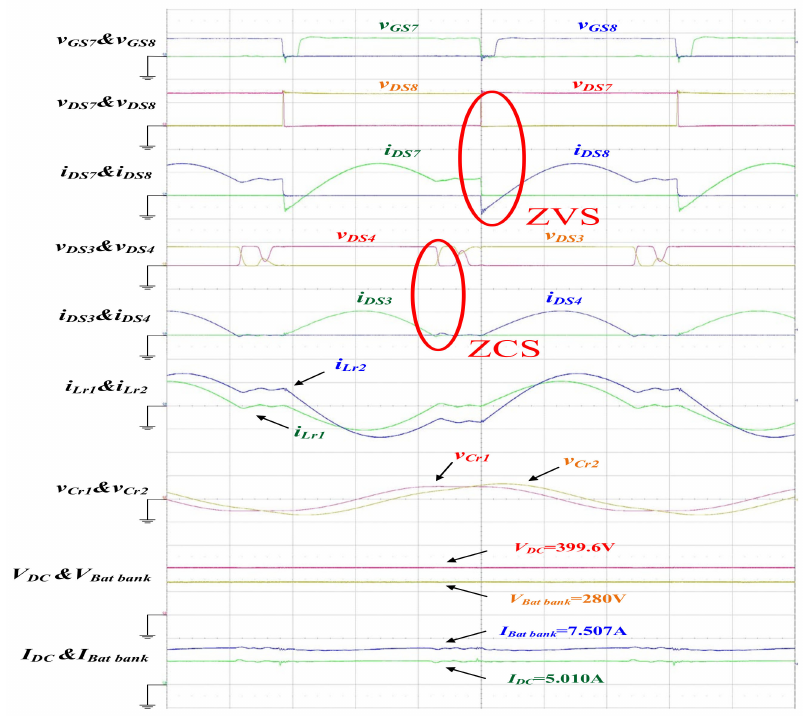
Figure 21. Waveforms obtained when the input battery voltage, V Bat bank , was 280 V and the fabricated converter was operated at full load ( v GS 7&8 : 20 V/div; v DS 7&8 , V DC , V Bat bank : 200 V/div; v Cr 1&2 , v DS 3&4 : 500 V/div; i DS 7&8 , i Lr 1&2 , i DS 3&4 : 10 A/div; I Bat bank , I DC : 5 A/div).